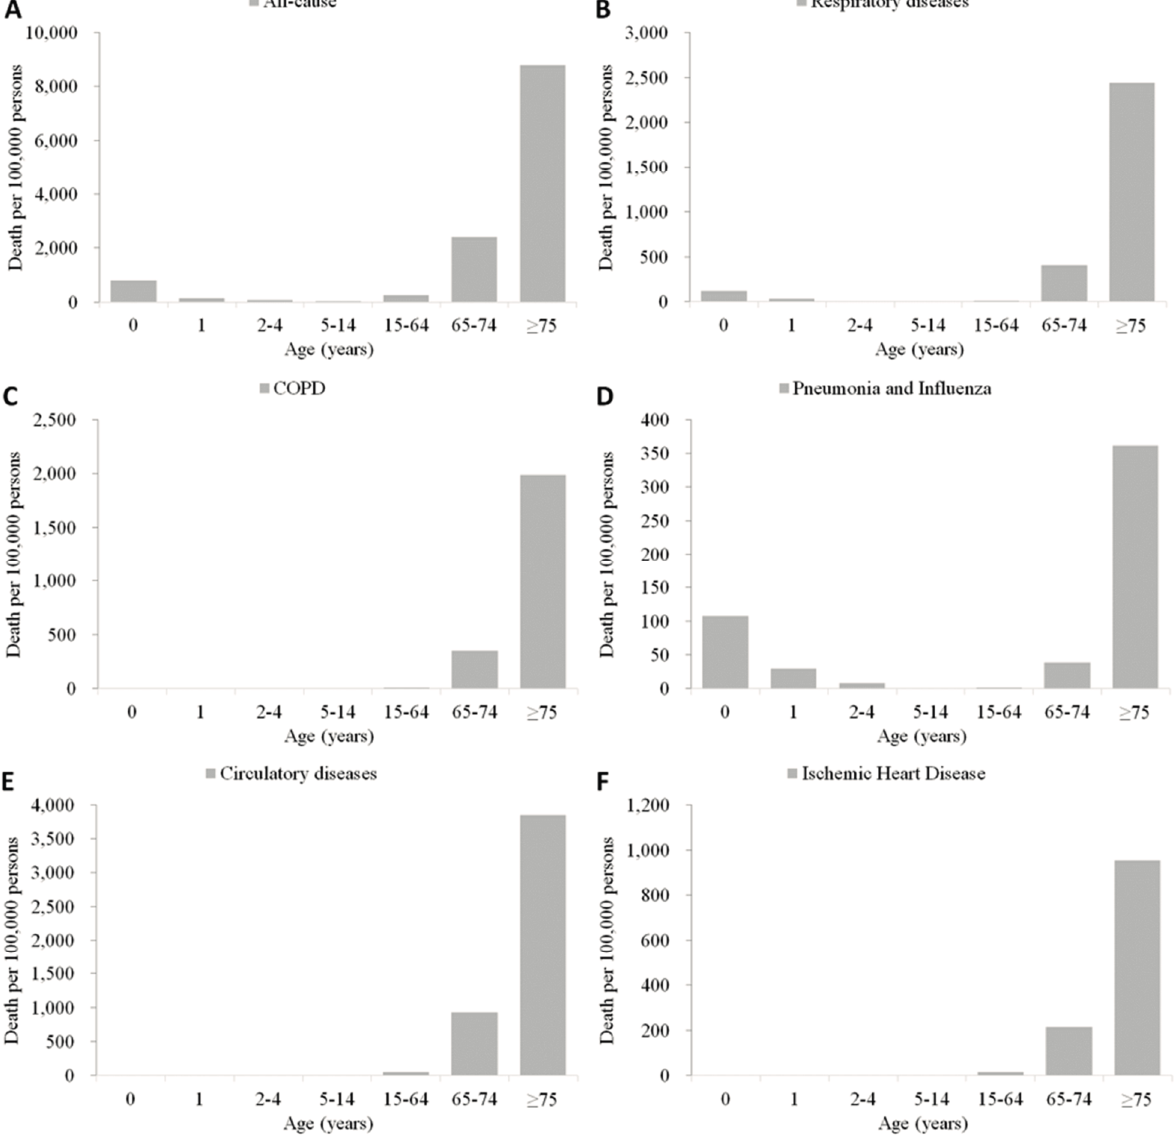
Figure 3. Average mortality rates by death cause and age group in Southern China, 2004–2010. ( A ) All-cause; ( B ) Respiratory diseases; ( C ) COPD; ( D ) Pneumonia and influenza; ( E ) Circulatory diseases; ( F ) Ischemic heart